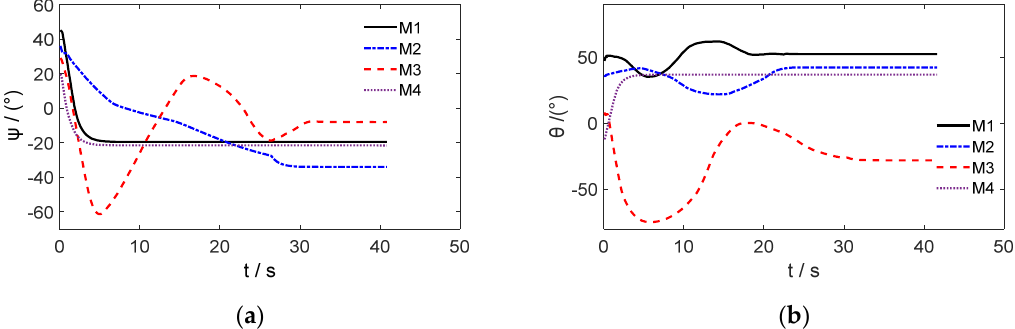
Figure 12. Velocity-inclination change curve of each follower missile during the cooperative attack on target 1 based on the MPC method: ( a ) Trajectory deflection curve; ( b ) Trajectory inclination curve.